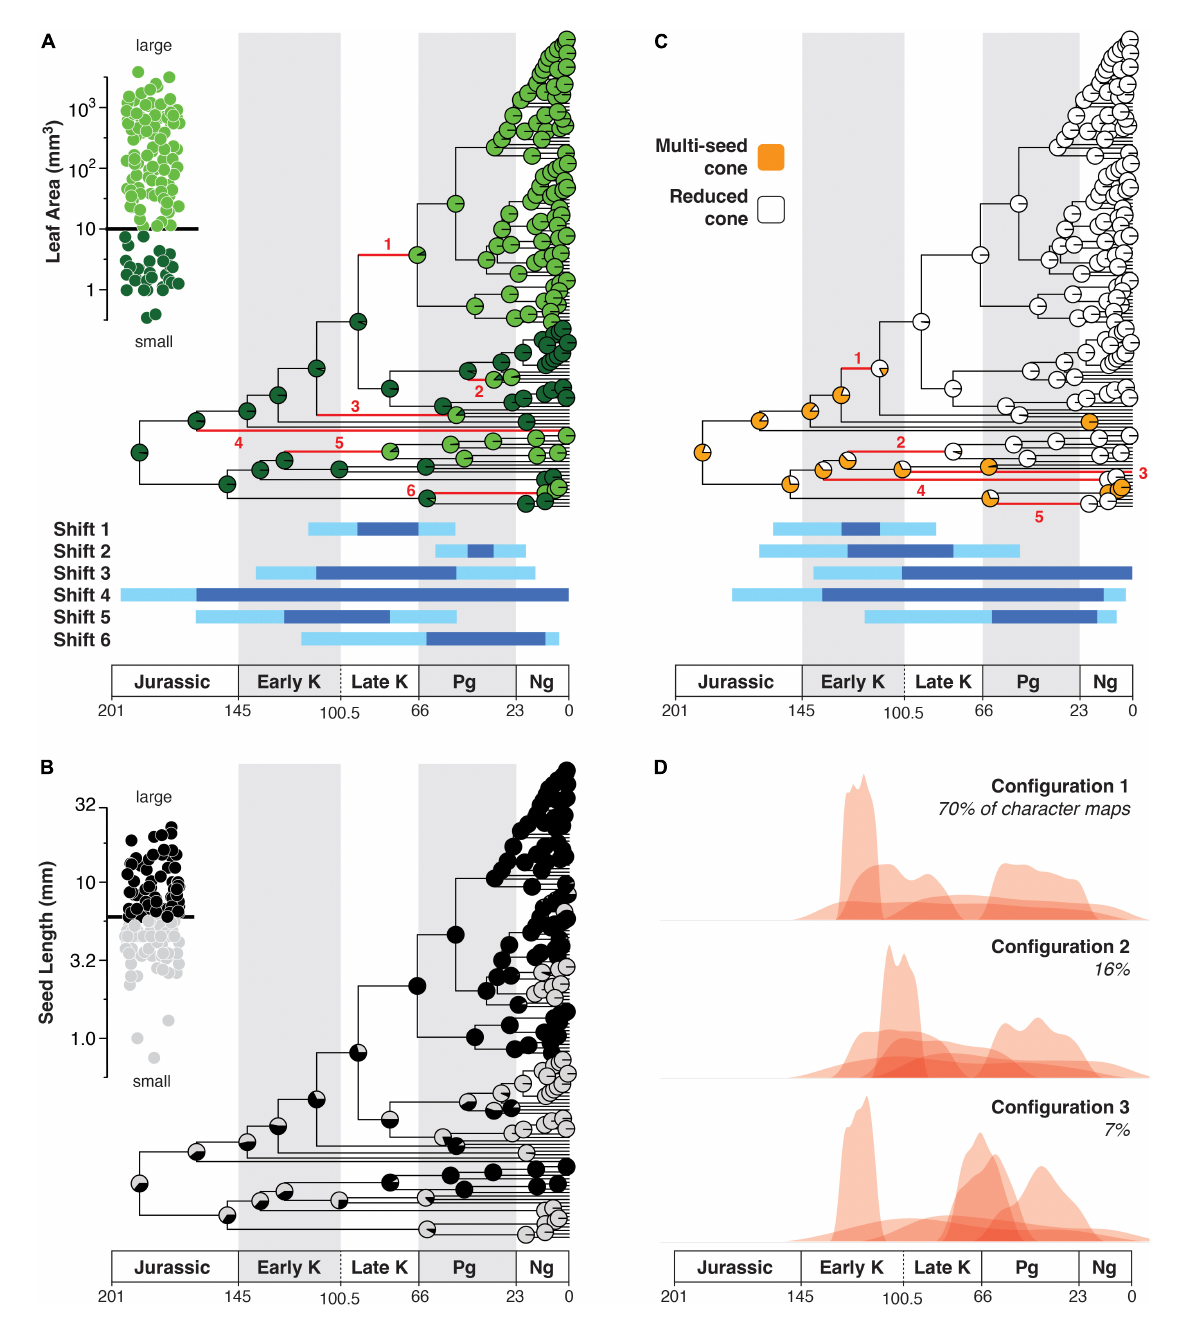
FIGURE3 Ancestral state reconstructions of discrete Podocarpaceae characters using a molecular phylogeny. (A) Reconstruction of leaf area as a binary trait, binned into “small” and “large” leaves based on a threshold estimated value of 10 mm 2 . The full distribution of extant leaf area estimates with the threshold value is shown in the stripchart to the left of the tree. Branches where shifts to large leaf sizes are inferred to have occurred are numbered and highlighted in red. Age ranges for these five shifts are shown under the phylogeny; dark blue indicates the range in median estimated ages for the two nodes between which the shift is inferred to have occurred while light blue indicates the total possible age range (maximum HPD age of oldest node and minimum HPD age of youngest node). (B) Reconstruction of seed length as a binary trait, with the full distribution of seed lengths and the threshold value shown in the stripchart to the left of the tree. Here we show a cutoff value between “small” and “large” at the median seed length (50th percentile; 6 mm). Inferred shifts are ambiguous at deep nodes and are not shown in detail (see main text for discussion). (C) Reconstruction of multi-seeded cones, with inferred shifts to reduced structures numbered and highlighted in red; age ranges for these shifts are shown below the phylogeny as in panel (A) . (D) Scaled frequency distributions for the ages of inferred shifts from multi-seeded cones to reduced cones in the three most common character histories (“configurations”) from stochastic character mapping. Configurations and associated frequency distributions are based on 1000 simulated character